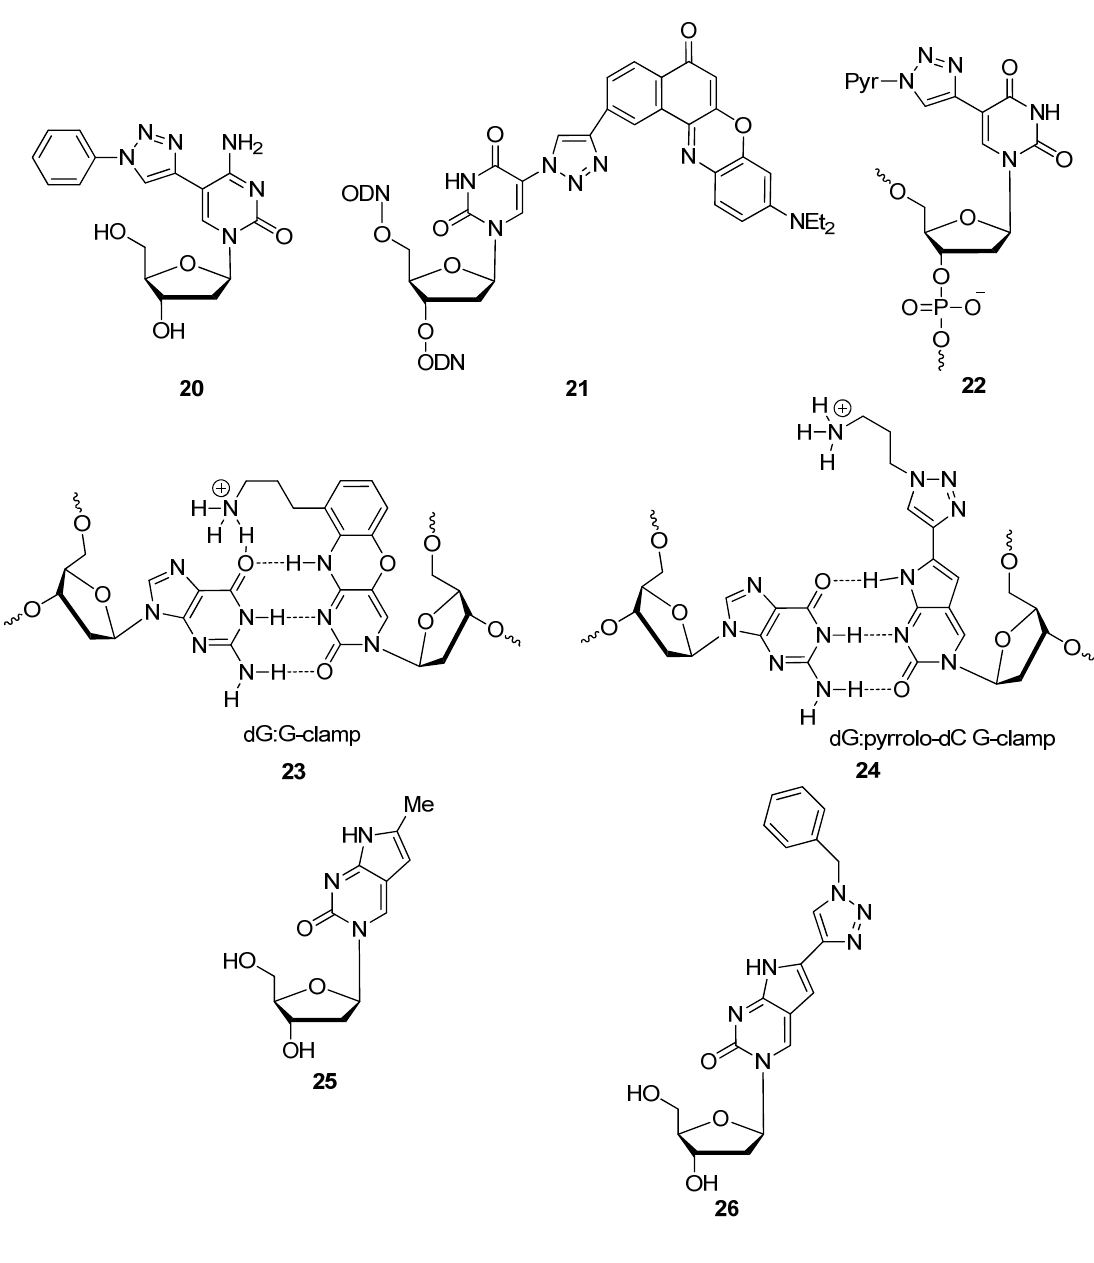
Figure 4. Triazole-modified nucleic acid-based compounds with fluorescent properties which also serve as precursors for other